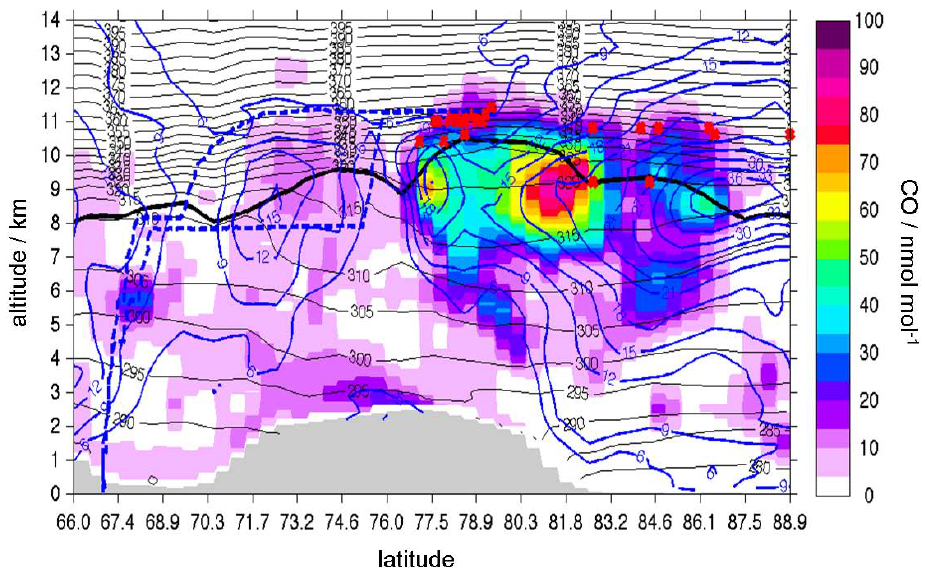
Fig. 8. Cross section of the FLEXPART Asian anthropogenic excess-CO tracer (see black line in Fig. 6h). Colours represent the modelled Asian excess-CO above atmospheric background values (see colour-scale on the right). The dashed blue line shows the Falcon flight path on 10 July. Also given are the 2PVU dynamical tropopause (thick black line), isentropes (thin black lines), and isotaches (thin blue lines), as calculated from ECMWF